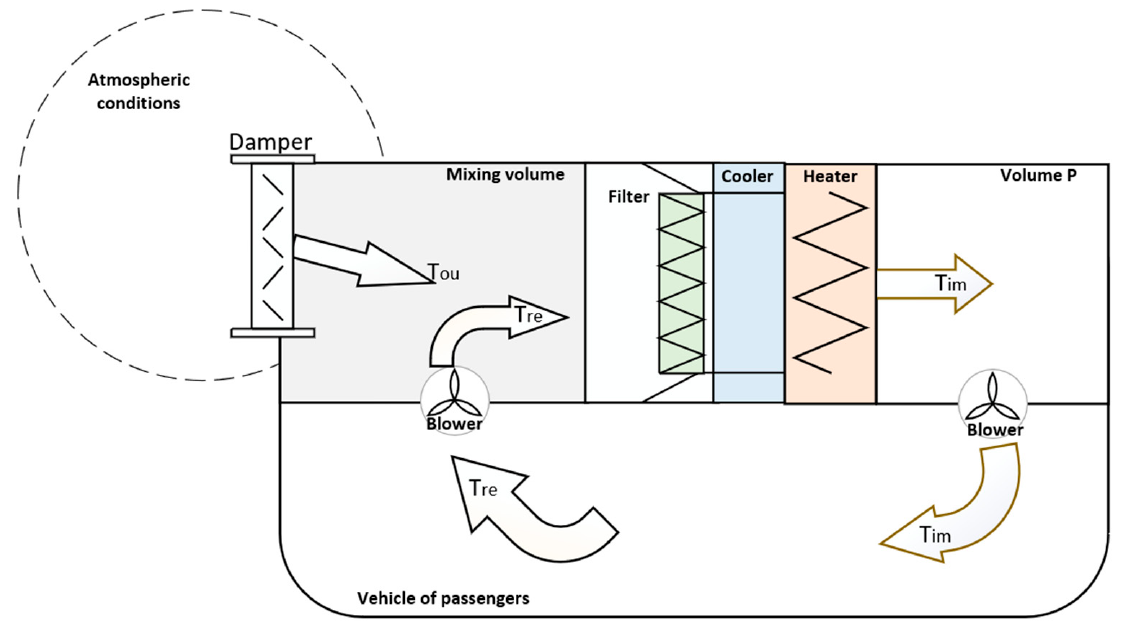
Figure 8. Ventilation system, circulation of air flow.